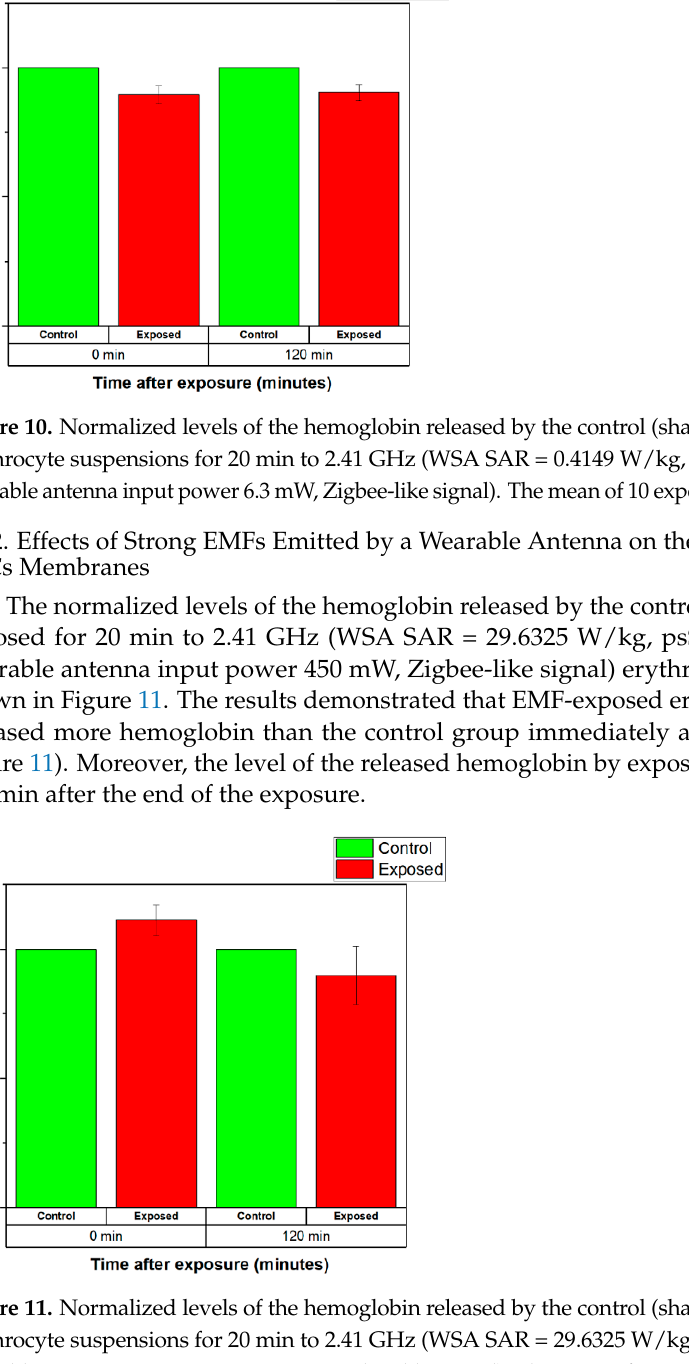
13 of 19 Figure 9. Normalized levels of the hemoglobin released by the control (sham-exposed) and exposed erythrocyte suspensions for 120 min to 2.41 GHz (WSA SAR = 0.4149 W/kg, psSAR1g = 0.5758 W/kg, wearable antenna input power 6.3 mW, Zigbee-like signal). The mean of 7 experiments ± SEM is shown. The normalized levels of the hemoglobin released by the control (sham-exposed) and